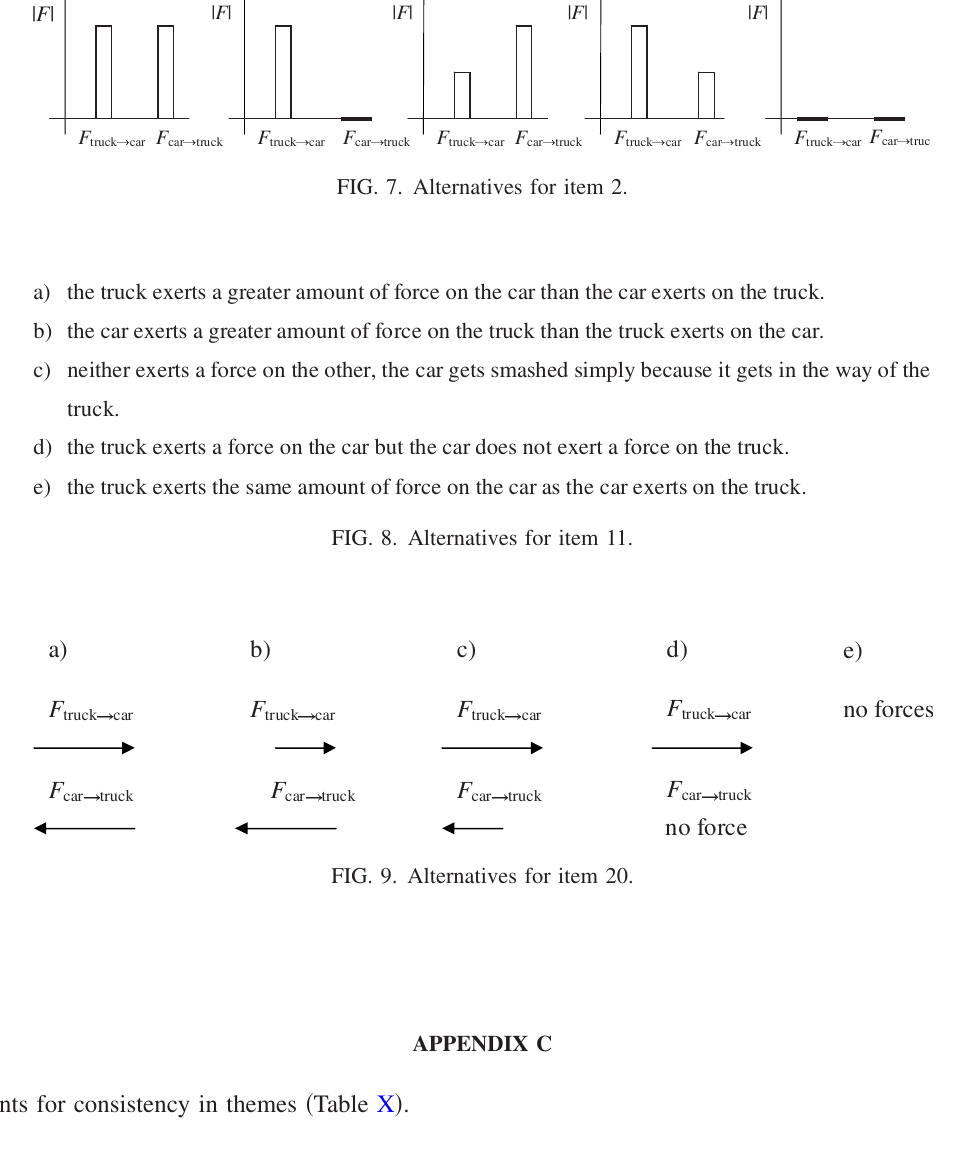
TABLE X. Students’ (cid:1) n =168 (cid:2) percentage of average points for representational and scientific consistency in themes.